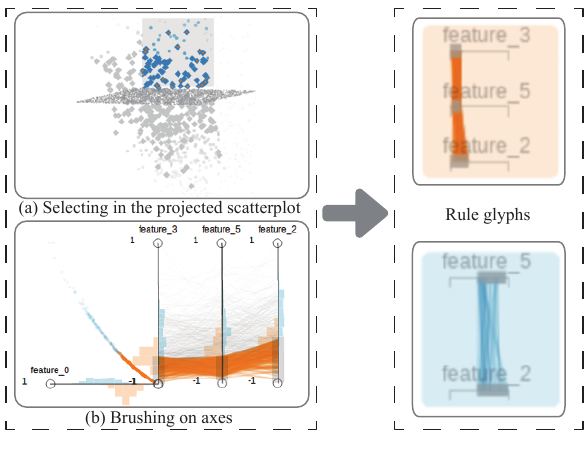
Fig. 8 Two ways of constructing